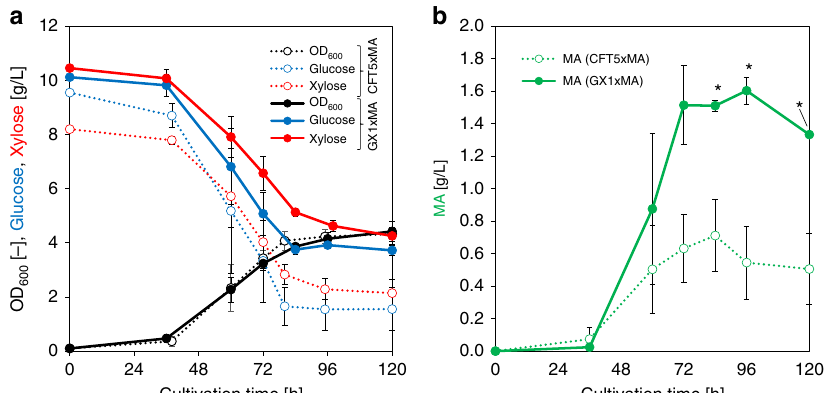
Fig. 5 Culture pro fi les of cis,cis -muconic acid (MA)-producing strains in M9 minimal medium. a Black, blue, and red symbols indicate bacterial cell growth, glucose consumption, and xylose consumption, respectively. b Green symbols indicate the produced amounts of MA. All open and fi lled symbols indicate the results for the CFT5xMA and GX1xMA strains, respectively. The data are presented as the average of three independent experiments, and error bars indicate standard errors. P values were computed using the two-tailed Student ’ s t -test (* P < 0.05). Source data are provided as a Source Data fi le.